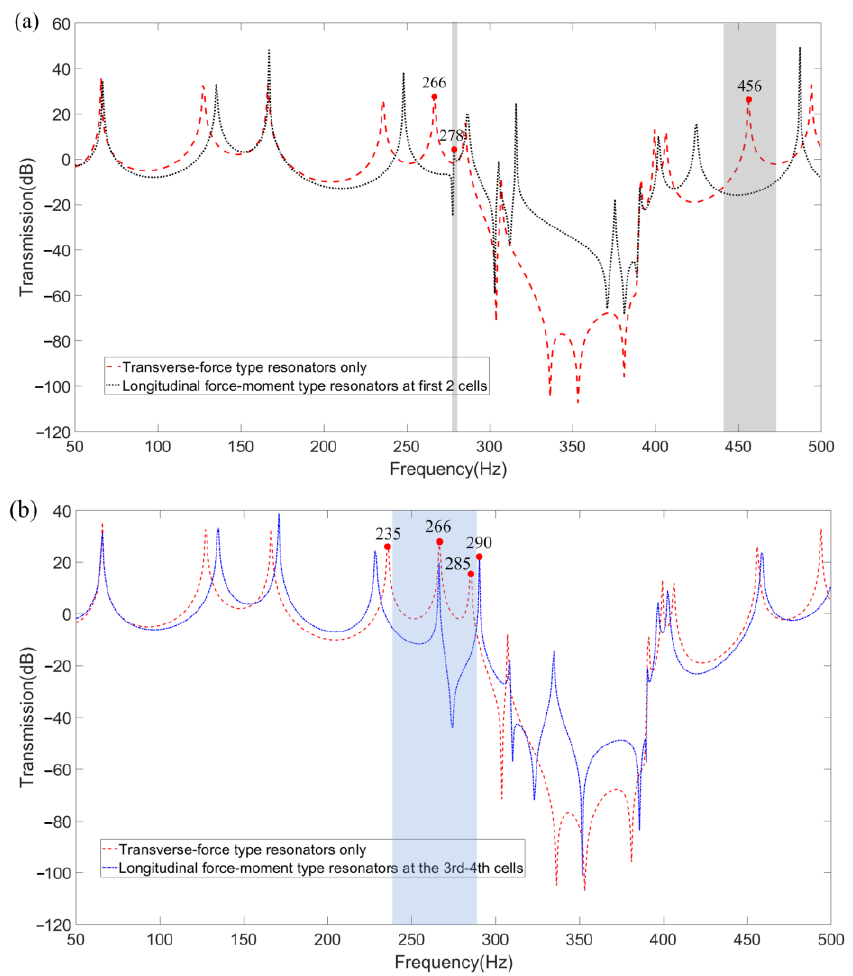
Figure 13. The comparison FRFs of the LR beam ( a ) suspended with transverse-force type resonators only and longitudinal-force-moment type resonators at the first two cells, ( b ) suspended with transverse-force type resonators only and longitudinal-force-moment type resonators at the 3rd − 4th cells.